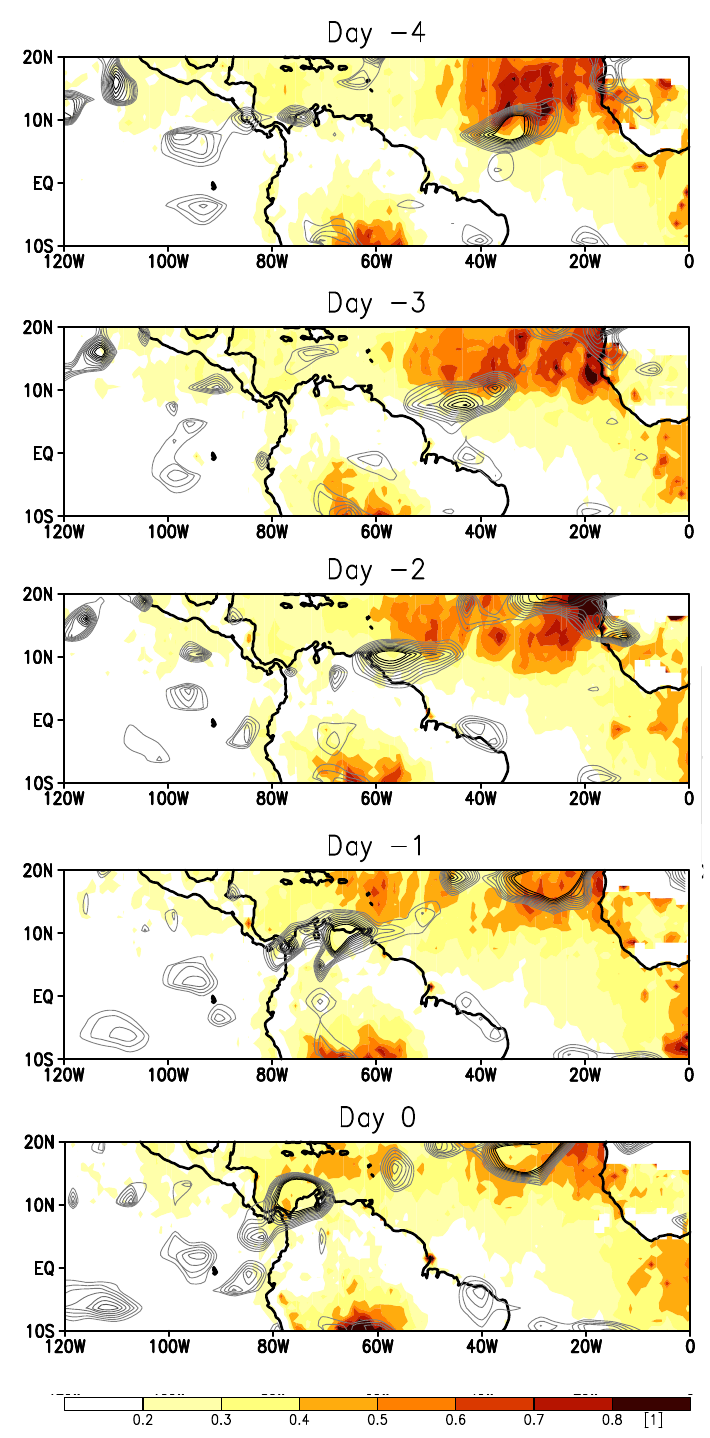
Figure 4. Composites of smoothed relative vorticity anomalies [s − 1 ] (black contour) and MODIS AOD [1] (shaded) from 4 days before (Day − 4) of the passage of a dry AEW over northern South